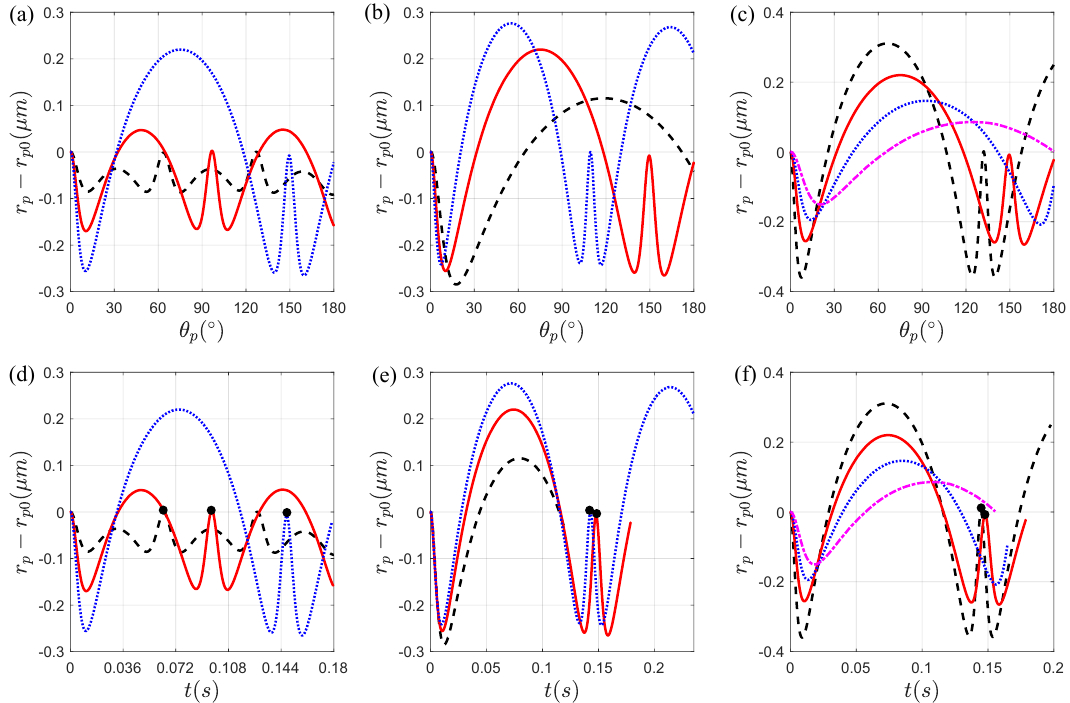
Figure A6. Effects of particle aspect ratio, AR , average radii, R avg , and initial radial position, r p 0 , values on the radial particle-wall separation, ∆ r p π and ∆ r p θ , of elliptical particles for the range 0 ◦ ≤ θ p ≤ 180 ◦ in the absence of a magnetic field. The ( a ) θ p and ( d ) time dependency on the aspect ratio effect on the particle’s radial position ( r p − r p 0 ): AR = 2 (dash line), AR = 3 (solid line), AR = 4 (dot line). The initial position is r p 0 = 12 µ m and the average channel radius is R avg = 175 µ m. The ( b ) θ p and ( e ) time dependency on the average radius effect on r p − r p 0 : R avg = 125 µ m (dash line), R avg = 175 µ m (solid line), R avg = 225 µ m (dot line). The particle’s aspect ratio and position are AR = 4, r p 0 = 12 µ m, and respectively. The ( c ) θ p and ( f ) time dependency of the particle’s initial radial positions on the effect on the radial position r p − r p 0 : r p 0 = 10 µ m (dash line), r p 0 = 12 µ m (solid line), r p 0 = 14 µ m (dot line), r p 0 = 16 µ m (dash-dot line). The particle’s aspect ratio and the average channel radius are AR = 4 and R avg = 175 µ m, respectively. The black dots in ( d , e , f ) represent the end of the particles’ π